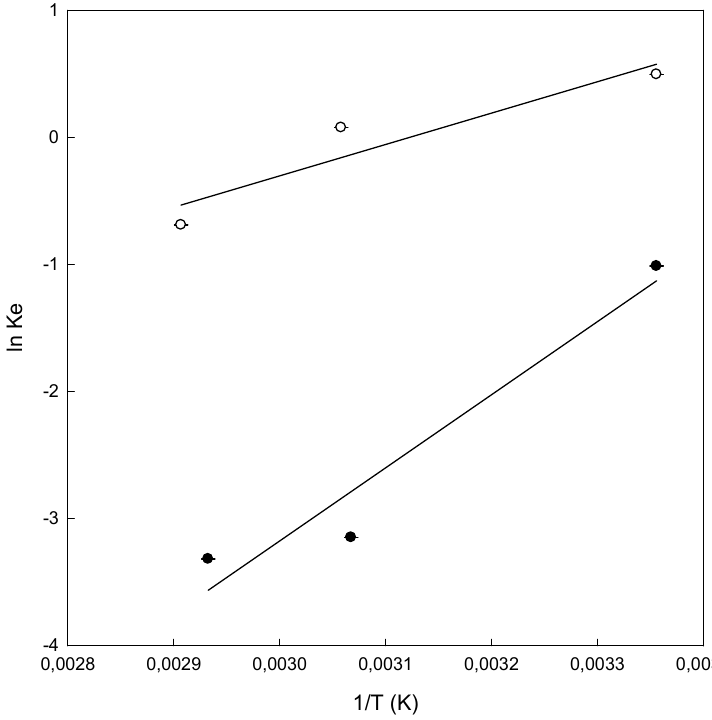
Figure 7. Van’t Hoff plot for the adsorption of Direct Blue 78 onto chitosan-NaOH ( ● ) and β -CDs-EPI ( ○ ) polymers at different temperatures. K e is the equilibrium constant and T the temperature. Table 4. Thermodynamic parameters for the adsorption of Direct Blue 78 onto chitosan-NaOH and β -CDs-EPI polymers at different